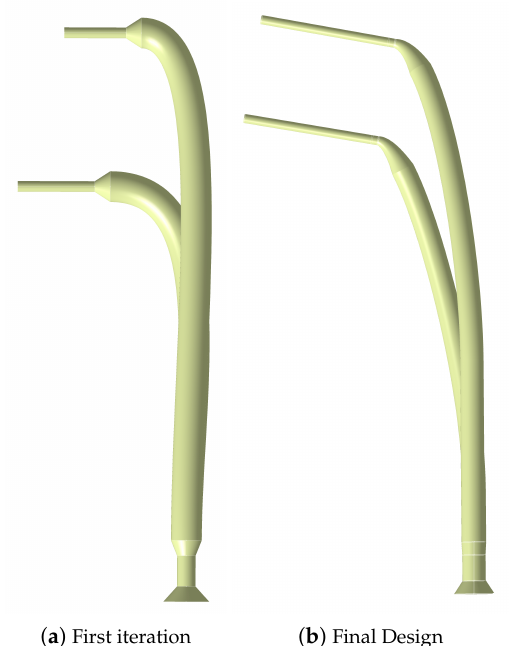
Figure 7. Evolution of the tube wall geometry during leakage optimization.